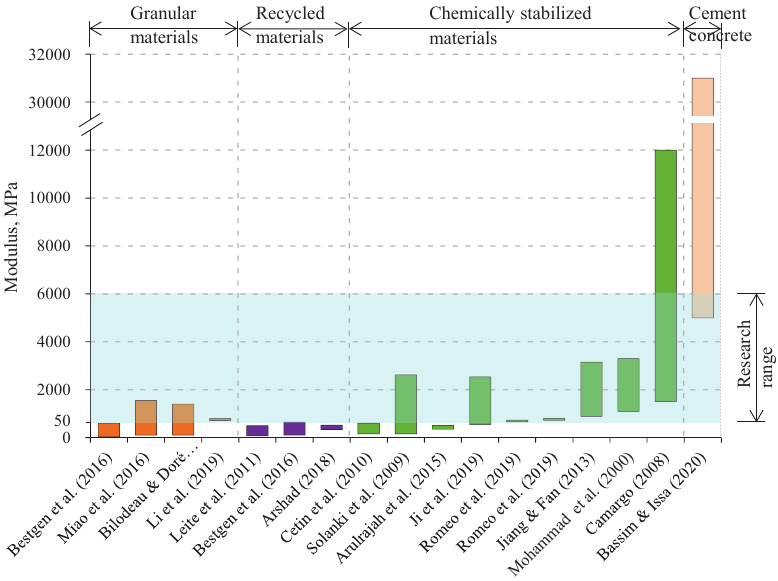
Figure 1. The modulus range of different materials of the base